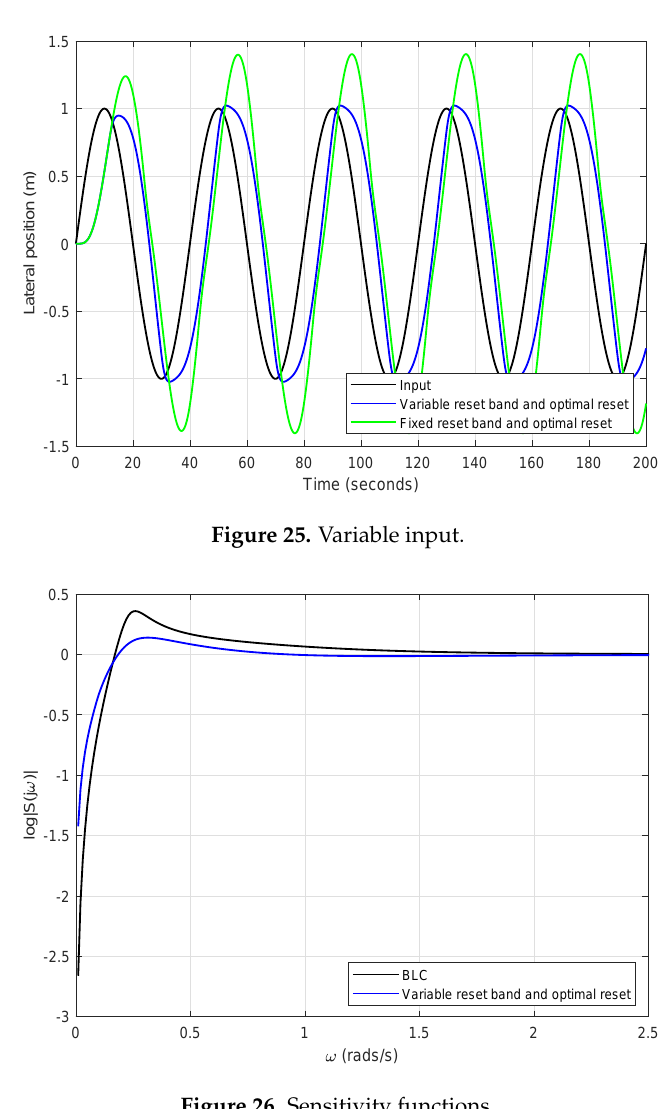
Figure 26. Sensitivity